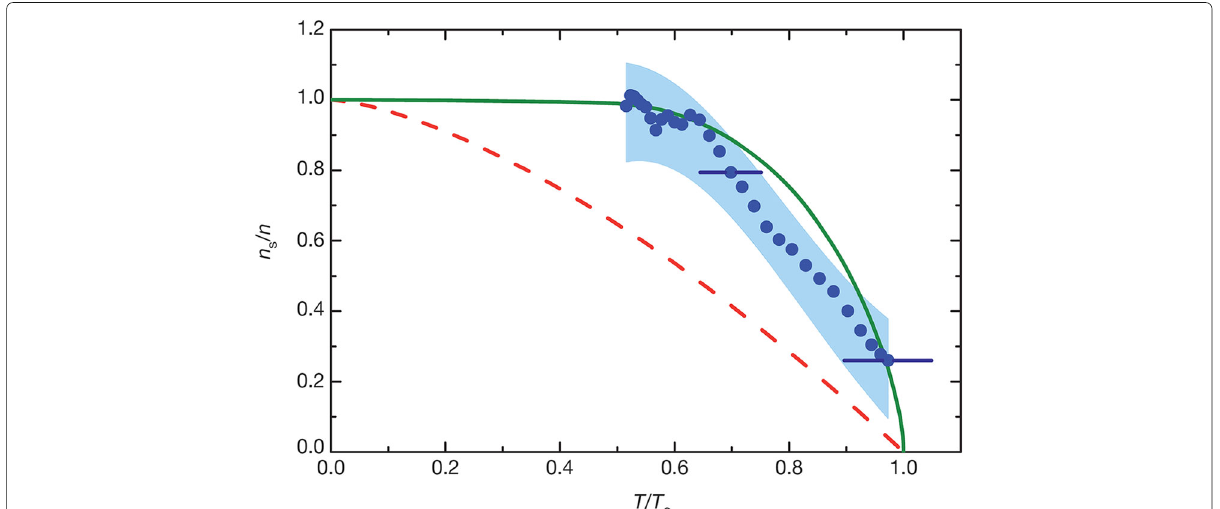
Fig. 11 The reconstructed superfluid fraction of a uniform unitary Fermi gas (symbols) as a function of T / T c , with uncertainty range indicated by shaded region. For comparison, the superfluid fraction of superfluid helium (green line) and the condensate fraction of an ideal Bose gas 1 − ( T / T c ) 3 / 2 (red dashed line) are also shown. From Ref. [23]